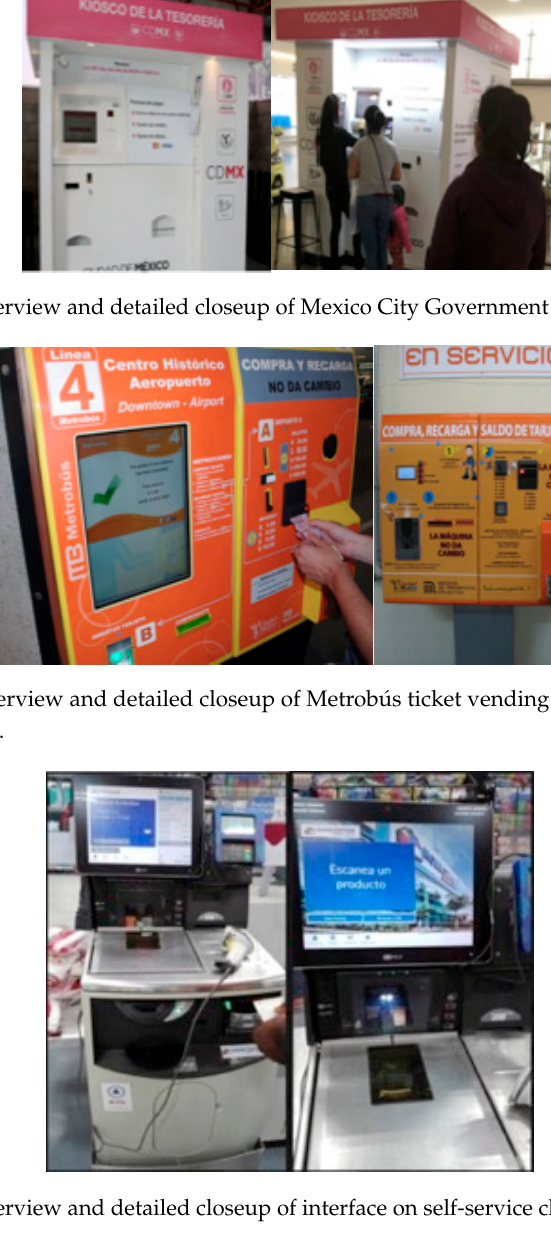
Figure 6. General overview and detailed closeup of Mexico City Government Treasury Kiosk, Mexico.